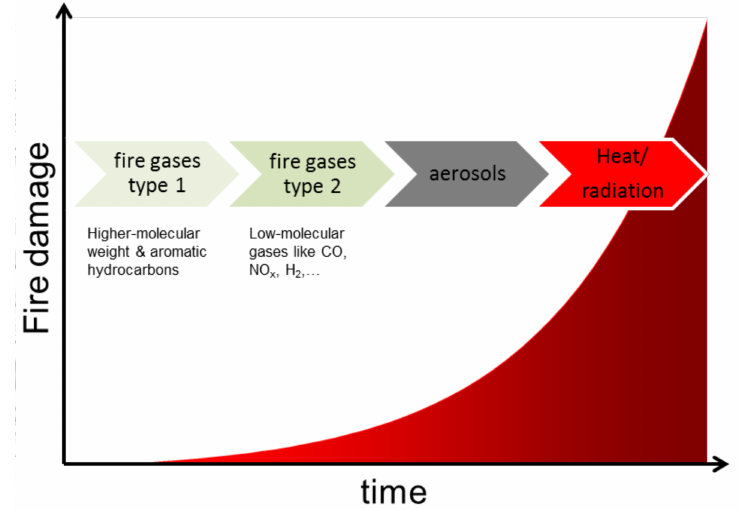
Figure 1. Scheme of the damage caused by fire outbreak occurring over time related to the fire indicators gas, aerosol, and